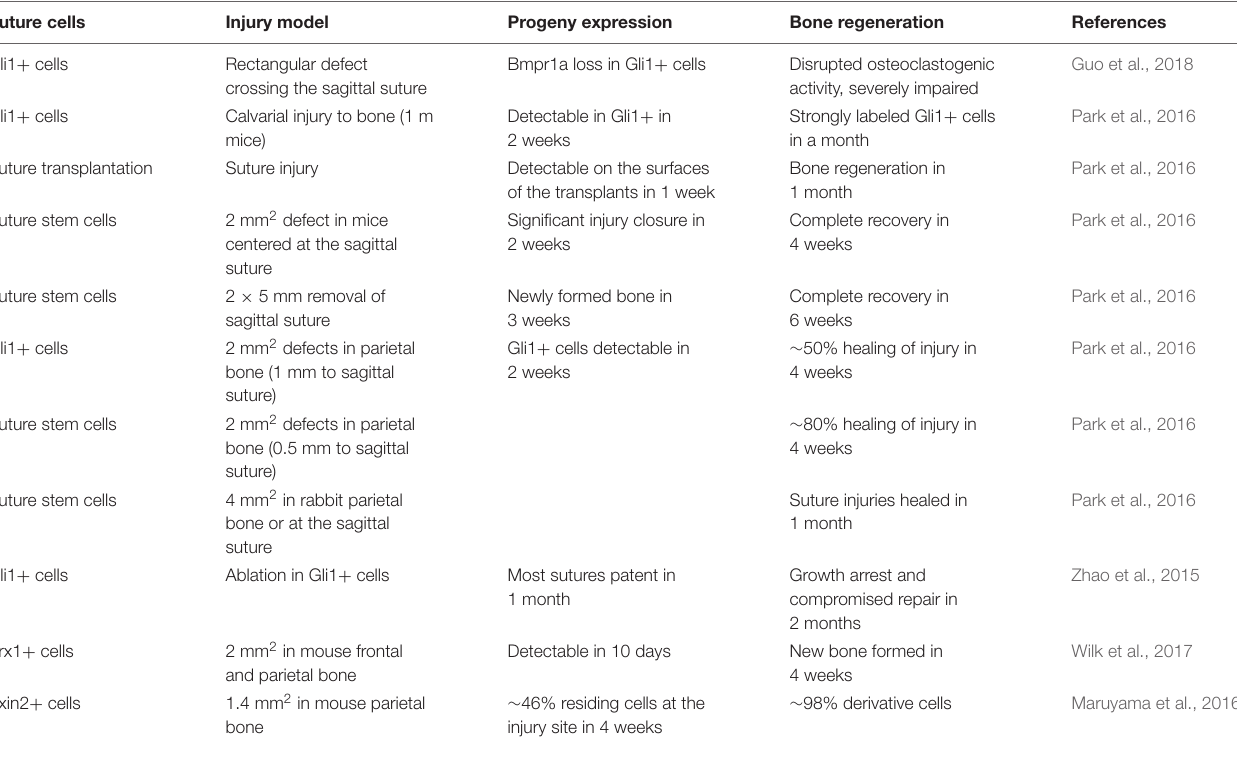
TABLE 3 | Calvarial injury model and stem-niches used in cranial bone